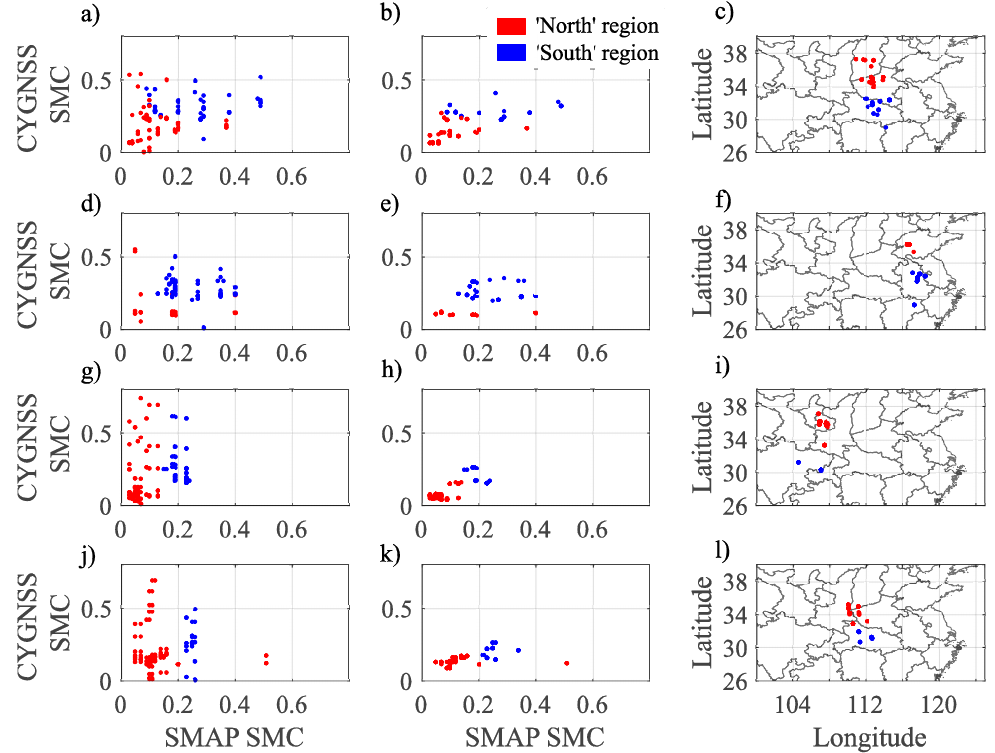
Figure 8. The sensitivity of the reflectivity correction ( R 2 and θ =30°) for different BSR and VOD values.